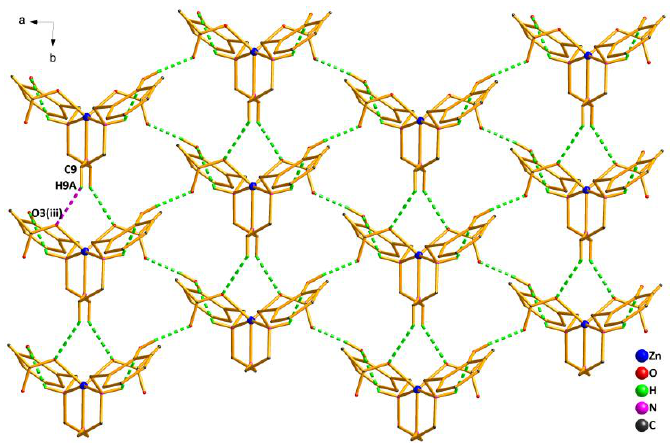
Figure 5. 2D wave-like network structure of Complex 2 via hydrogen bonds along the ab plane. Symmetry code: (iii) 1 − x,1 + y,1/2 − z.